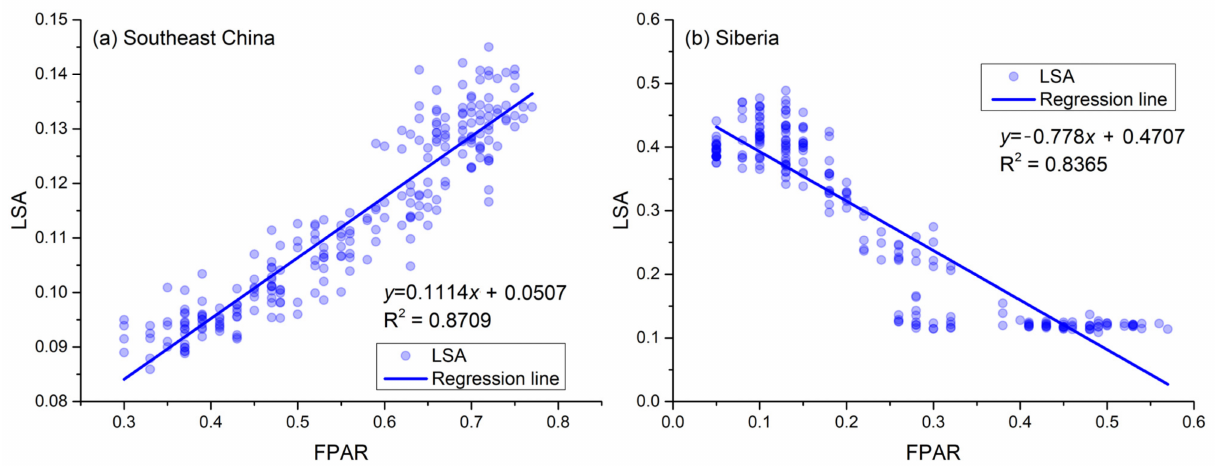
Figure 5. Scatter plot between monthly LSA and FPAR at the pixel scale. ( a ) A pixel in southeastern China (117.2 ◦ E, 28.0 ◦ N) and ( b ) a pixel in Siberia (95.5 ◦ E, 53.3 ◦